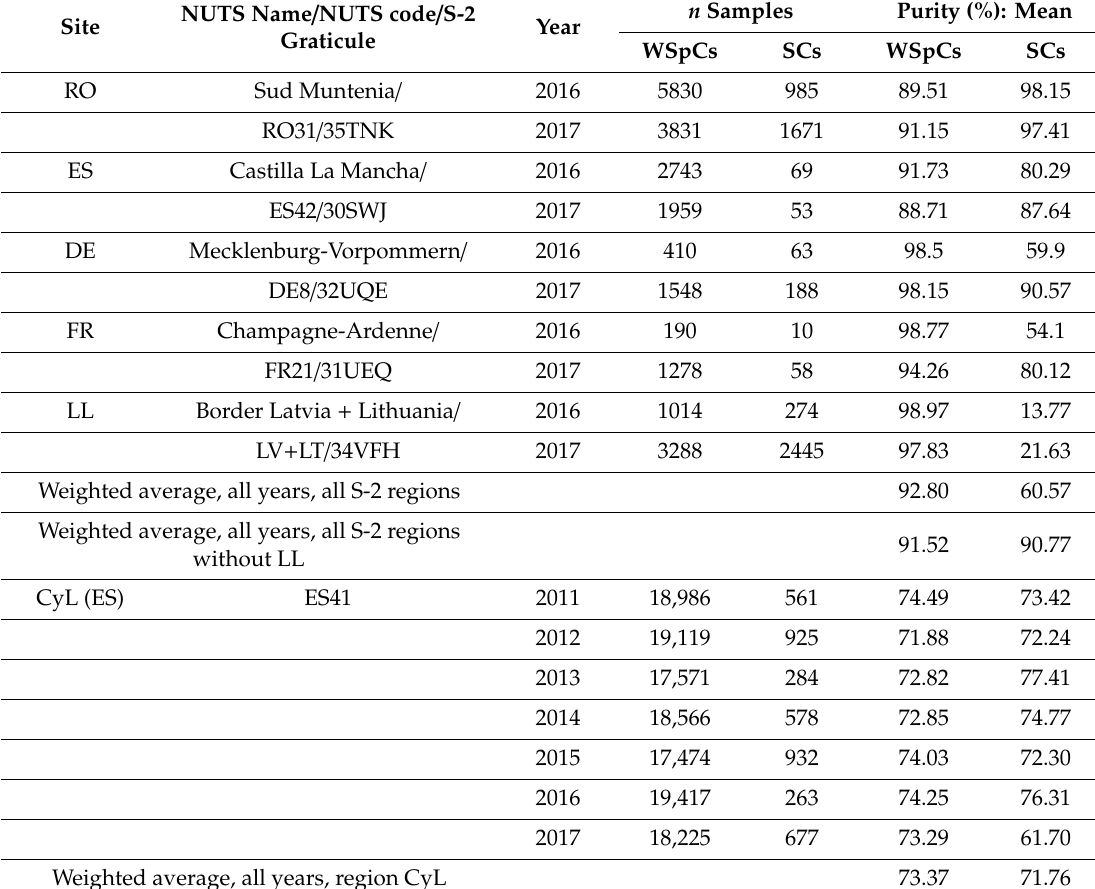
Table 3. Pixel purity for each validation